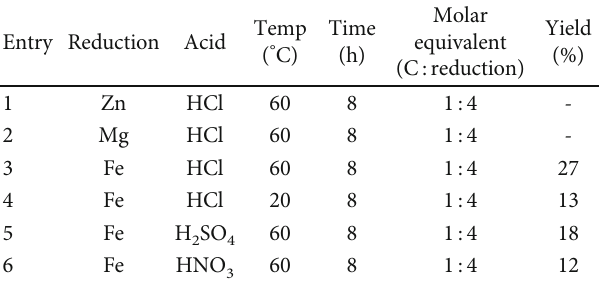
Table 2: E ff ect of di ff erent reaction condition on the yields of intermediate